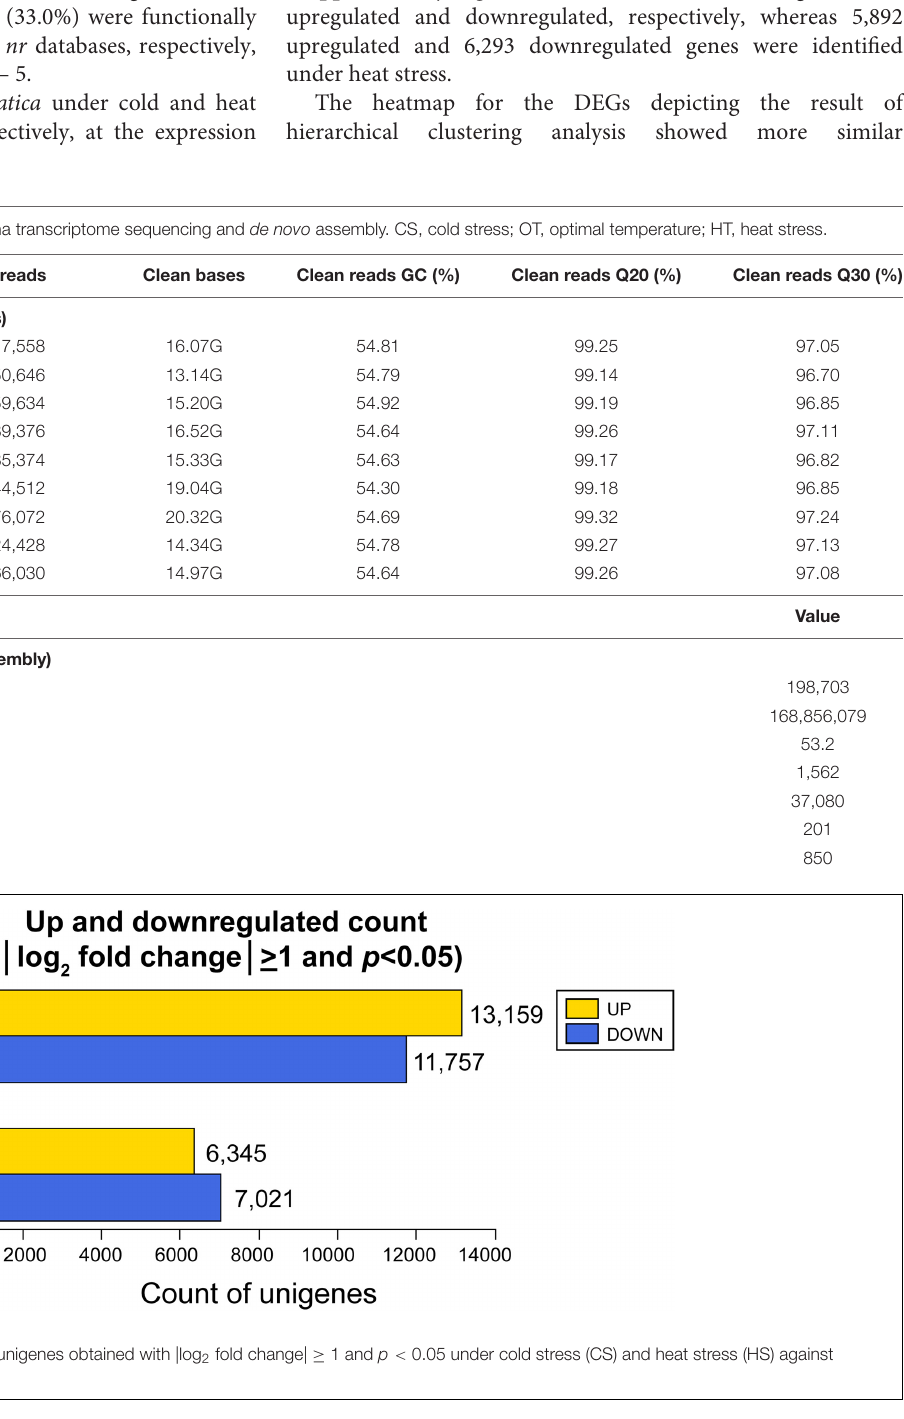
Frontiers in Marine Science |